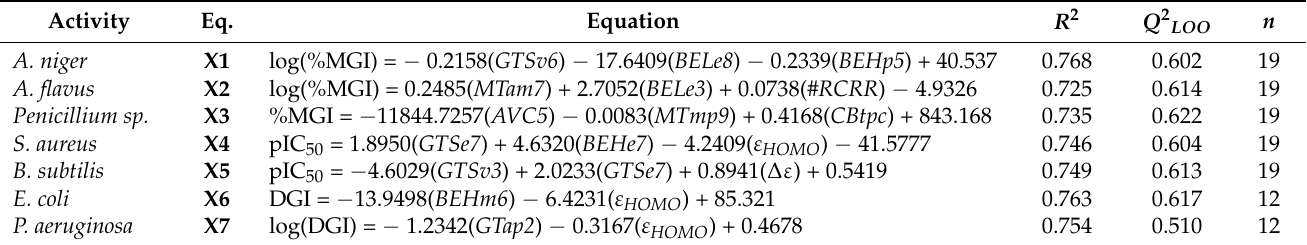
Table 3. Quantitative structure–activity relationship models of triazolothiadiazine compounds for antifungal and antibiotic activities.